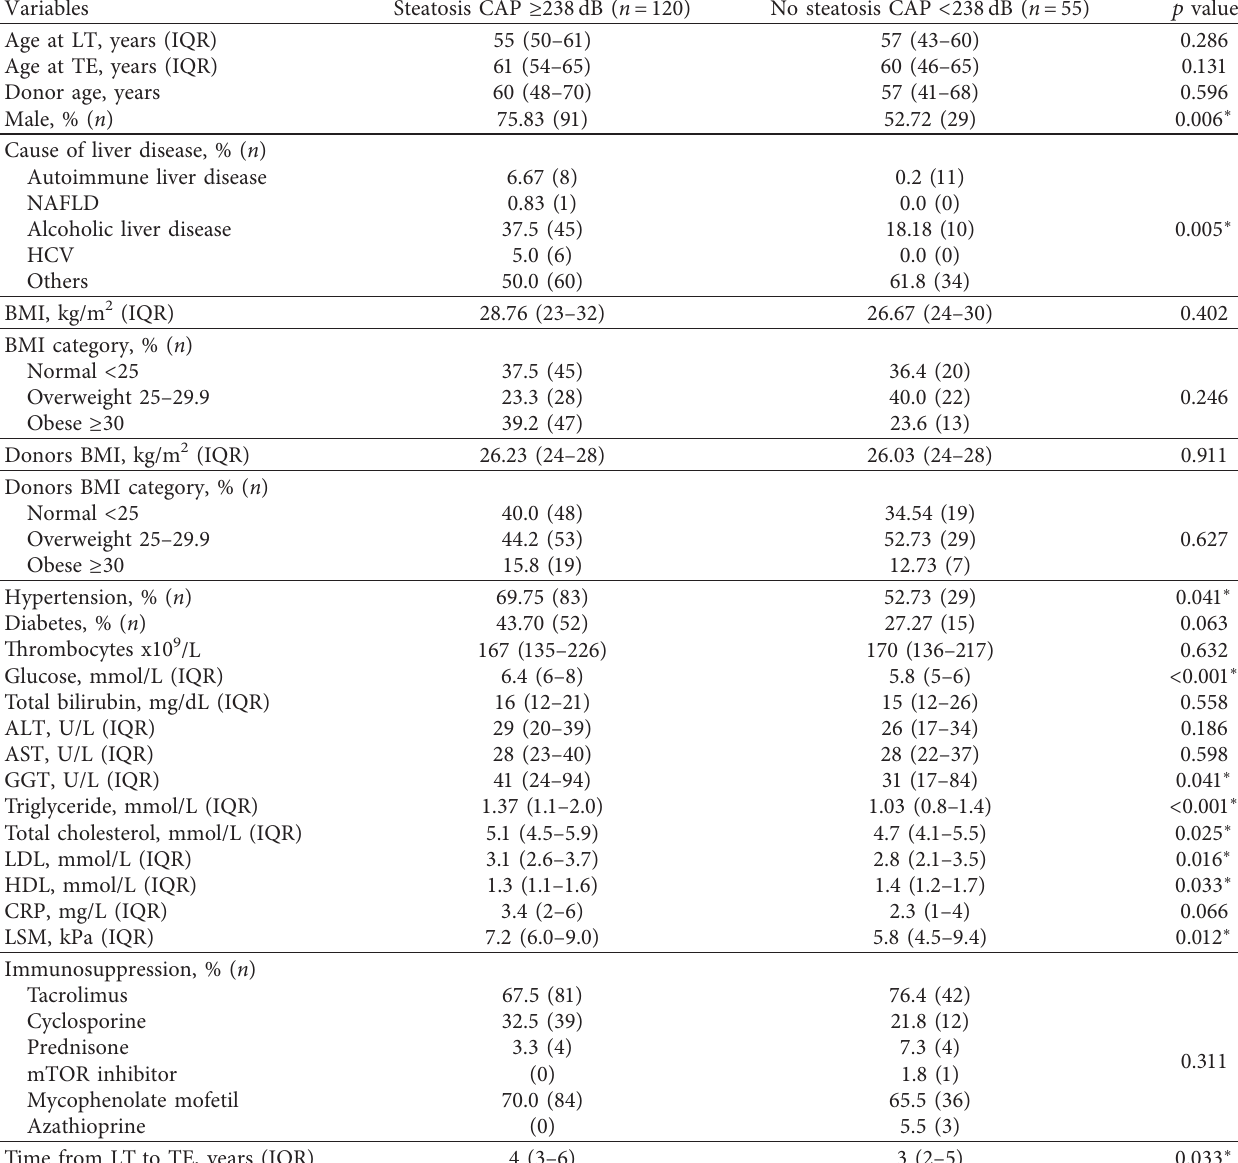
Table 1: Comparison of groups with and without steatosis (elevated CAP ≥